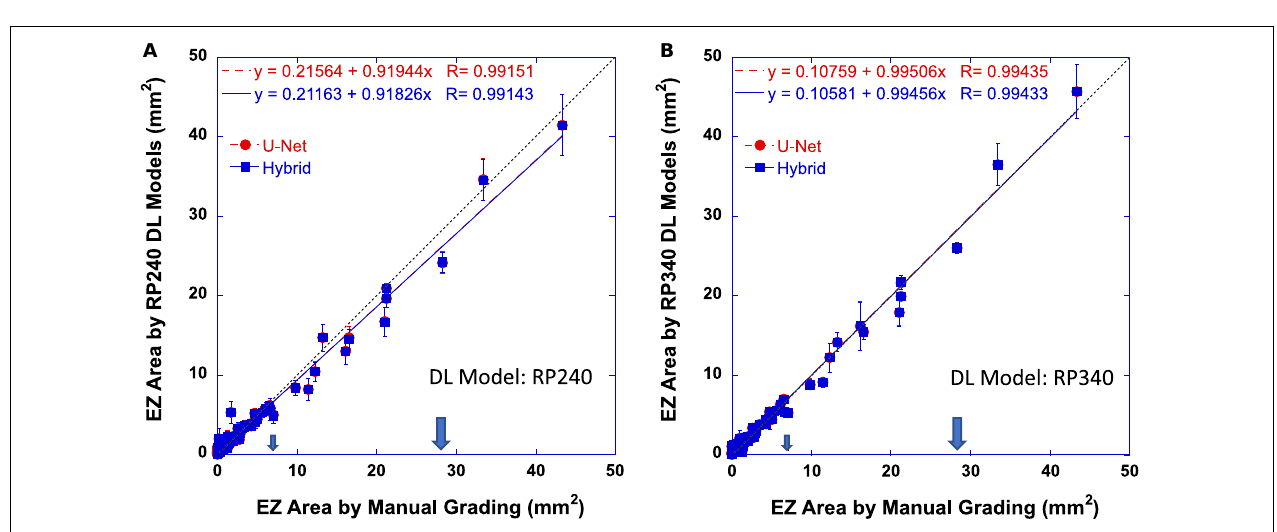
FIGURE 3 | Ellipsoid zone (EZ) areas determined automatically by RP240 (A) and RP340 (B) deep learning (DL) models as functions of that by the reading center. Red circles and dashed lines are the measurements of the U-Net model. Blue squares and solid lines are the measurements of the hybrid model. Dotted lines have a slope of one. The large arrows mark the central retinal area with a radius of 3 mm from the fovea (28.3 mm 2 ). The small arrows mark the central retinal area with a radius of 1.5 mm from the fovea (7.0 mm 2 ). Error bars indicate ± 1 standard deviation of three measurements by the same model type but trained three times separately on the same datasets. The equations in the plots were the Pearson correlation coefficients (R) and the linear regression fitting result of the data (red for U-Net and blue for the hybrid